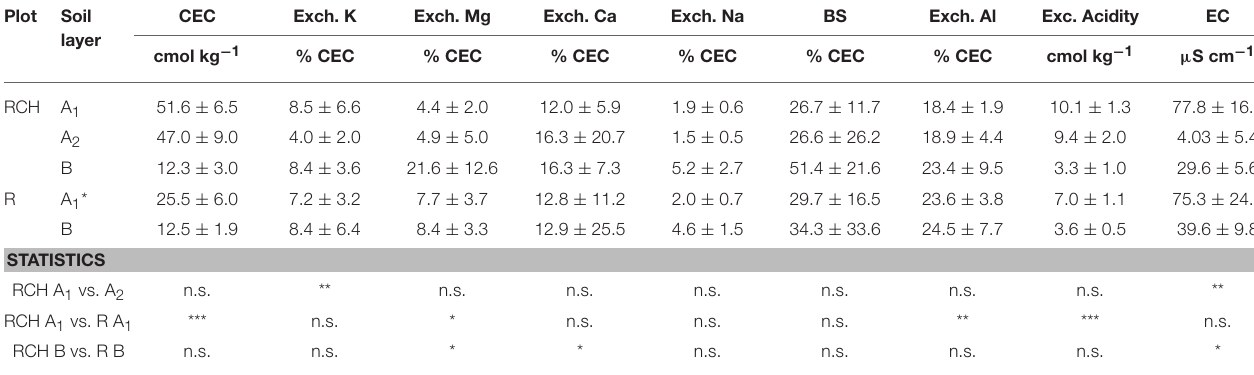
TABLE 4 | Cation exchange capacity (CEC), exchangeable acidity and Al, base saturation (BS), exchangeable cations, and soil electrical conductivity (EC) of relic charcoal hearths (RCH), and reference (R) soils divided into different soil layers. Plot Soil CEC Exch. K Exch. Mg Exch. Ca Exch. layer